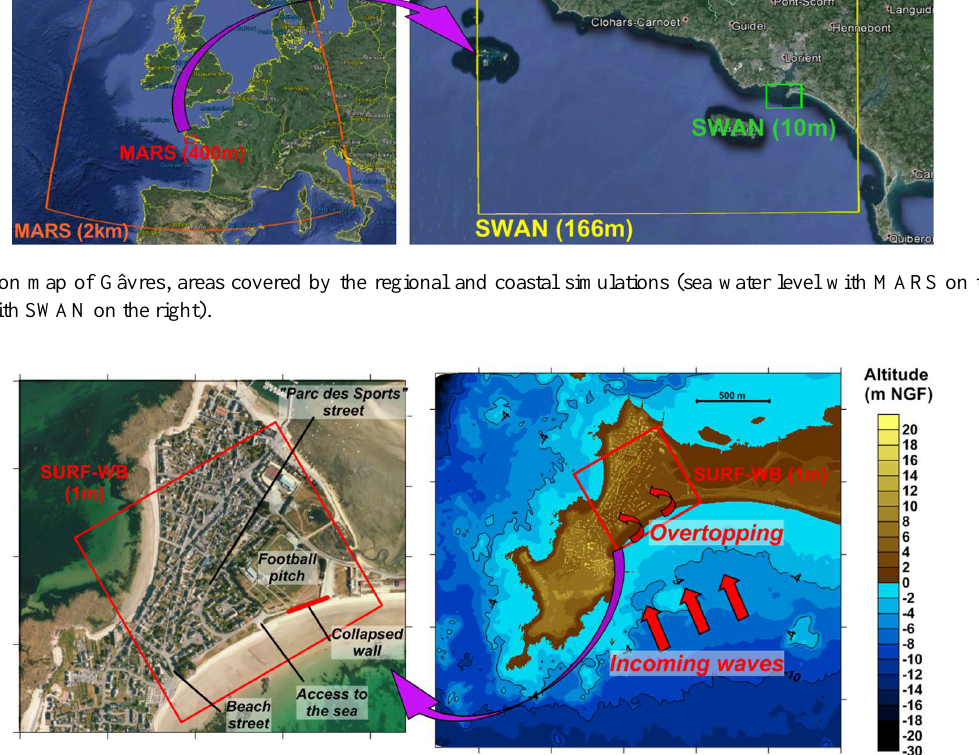
Figure 3. Area covered by the overtopping and flooding simulation: configuration of the site and main landmarks on the left, topography and bathymetry on the